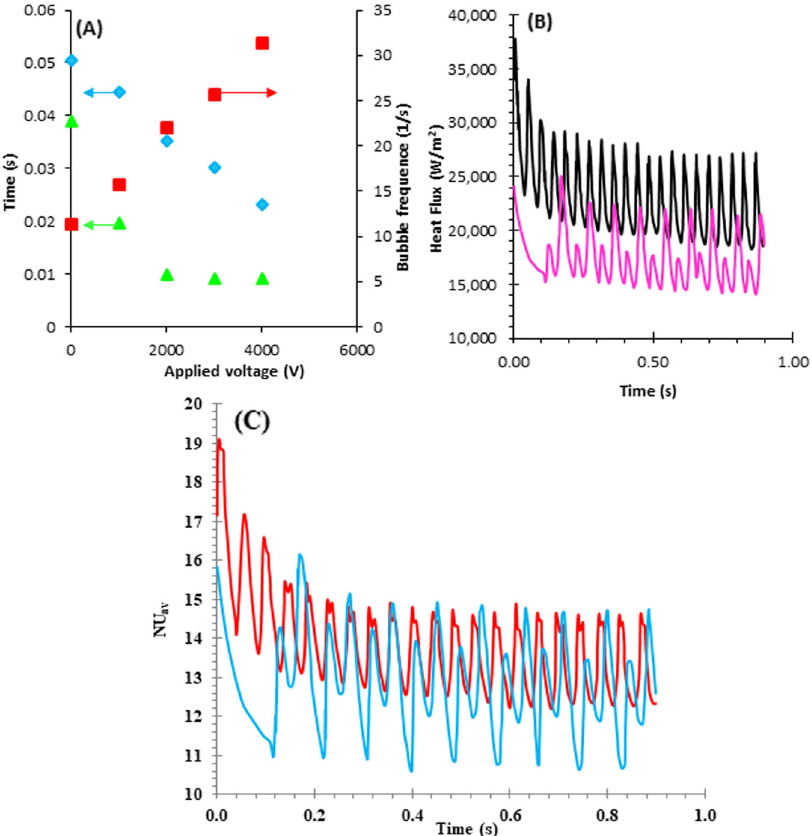
Fig. 5 Effect of applied voltage on the bubble behavior in the system and change in heat fl ux and Nusselt number with time. ( A )The change in growth time, waiting time, and average frequency as a function of applied voltage. ( B ) Integration of heat fl ux passing through the wall. ( C ) The trend of changes in the average Russell number on the wall versus time. Wating time ( ), growth time ( ), Frequency ( ), heat fl ux (Tw-Tsat = 7 °C)